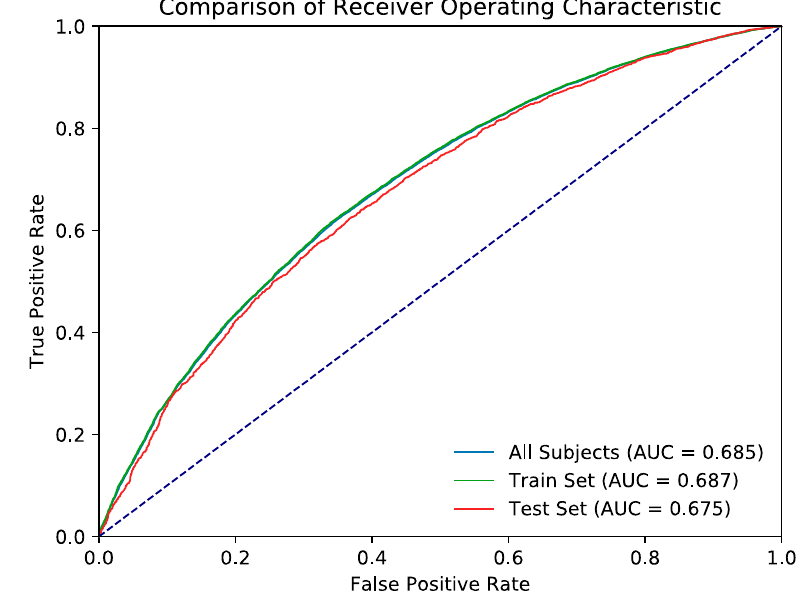
Figure 5. The ROC curve of the evaluation metrics of the artificial neural network classification model.